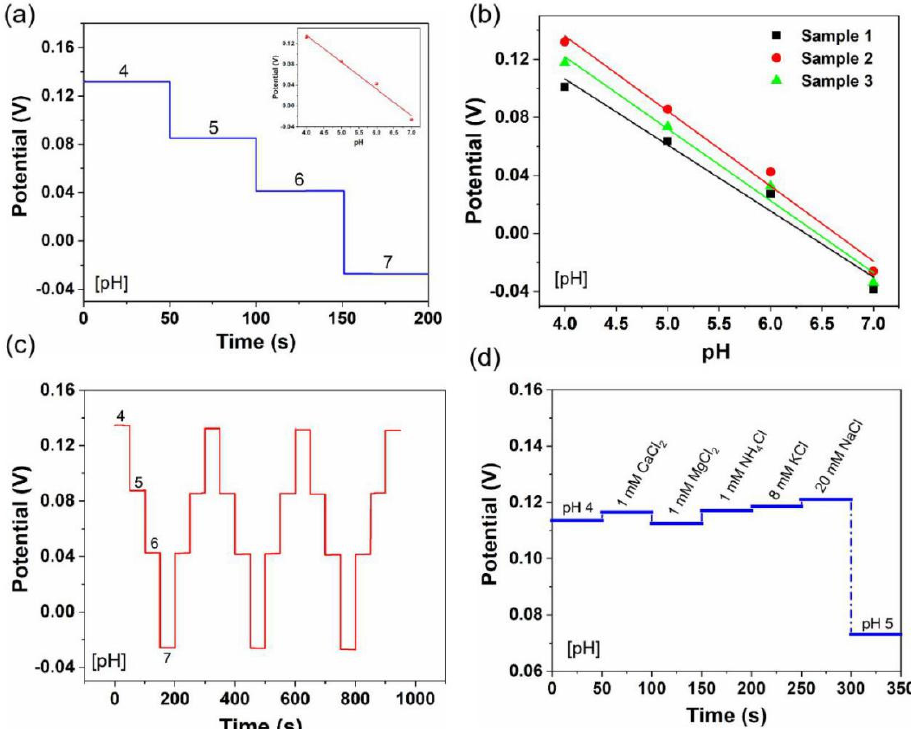
Figure 2. pH-sensing performance of flexible LIG-based sensors: ( a ) sensitivity, ( b ) reproducibility, ( c ) stability, and ( d ) selectivity. Inset in ( a ) is the corresponding calibration plot.